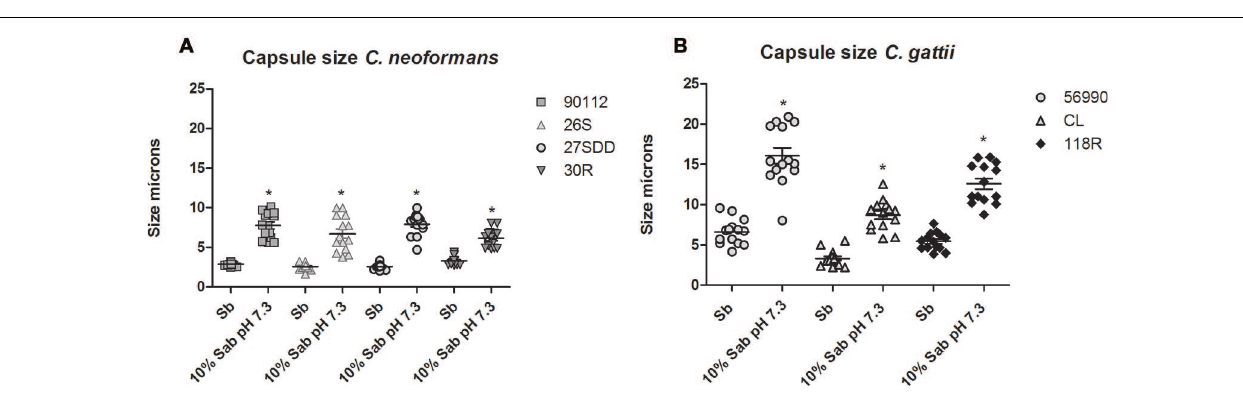
FIGURE 4 | In vitro capsule induction of clinical isolates of C. neoformans and C. gattii environmental isolates. (A) ATCC 90112 and clinical isolates of C. neoformans 26S, 27SDD, and 30R; (B) ATCC 56990 and environmental isolates of C. gattii CL and 118R. ∗ p <